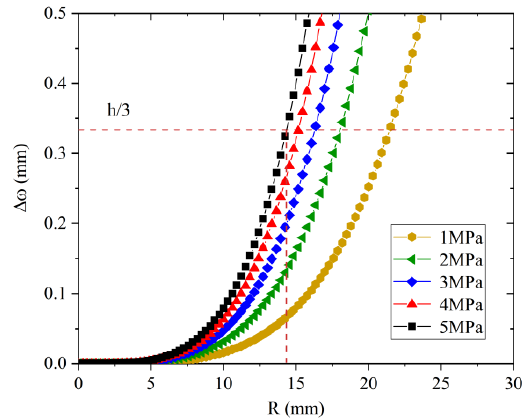
Figure 7. Relationship between the radius of the brass diaphragm and its deflection under different pressure loads.